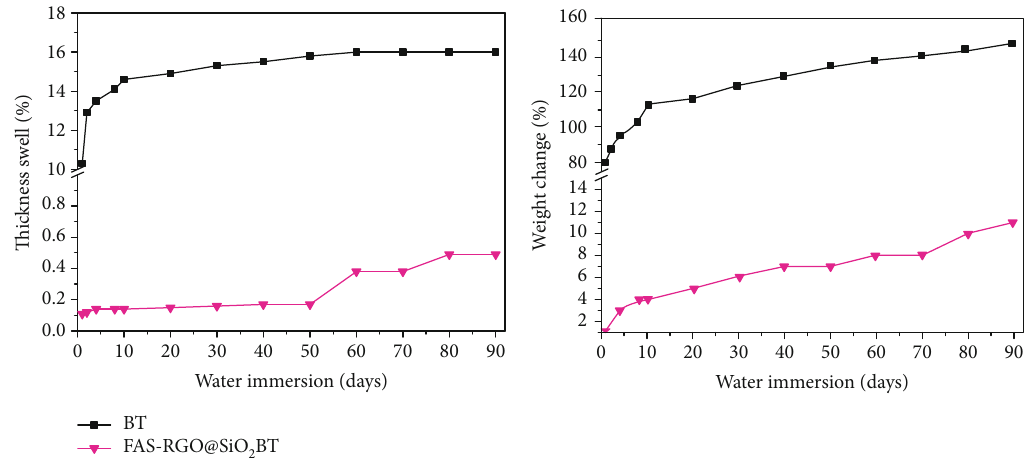
Figure 11: Water absorption and thickness swelling rate of BT and FAS-RGO@SiO